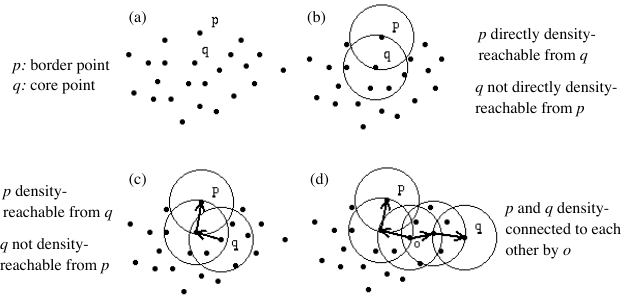
figure 3: density-reachability and density-connectivity Figure 3. Directly density-reachable, density reachable and